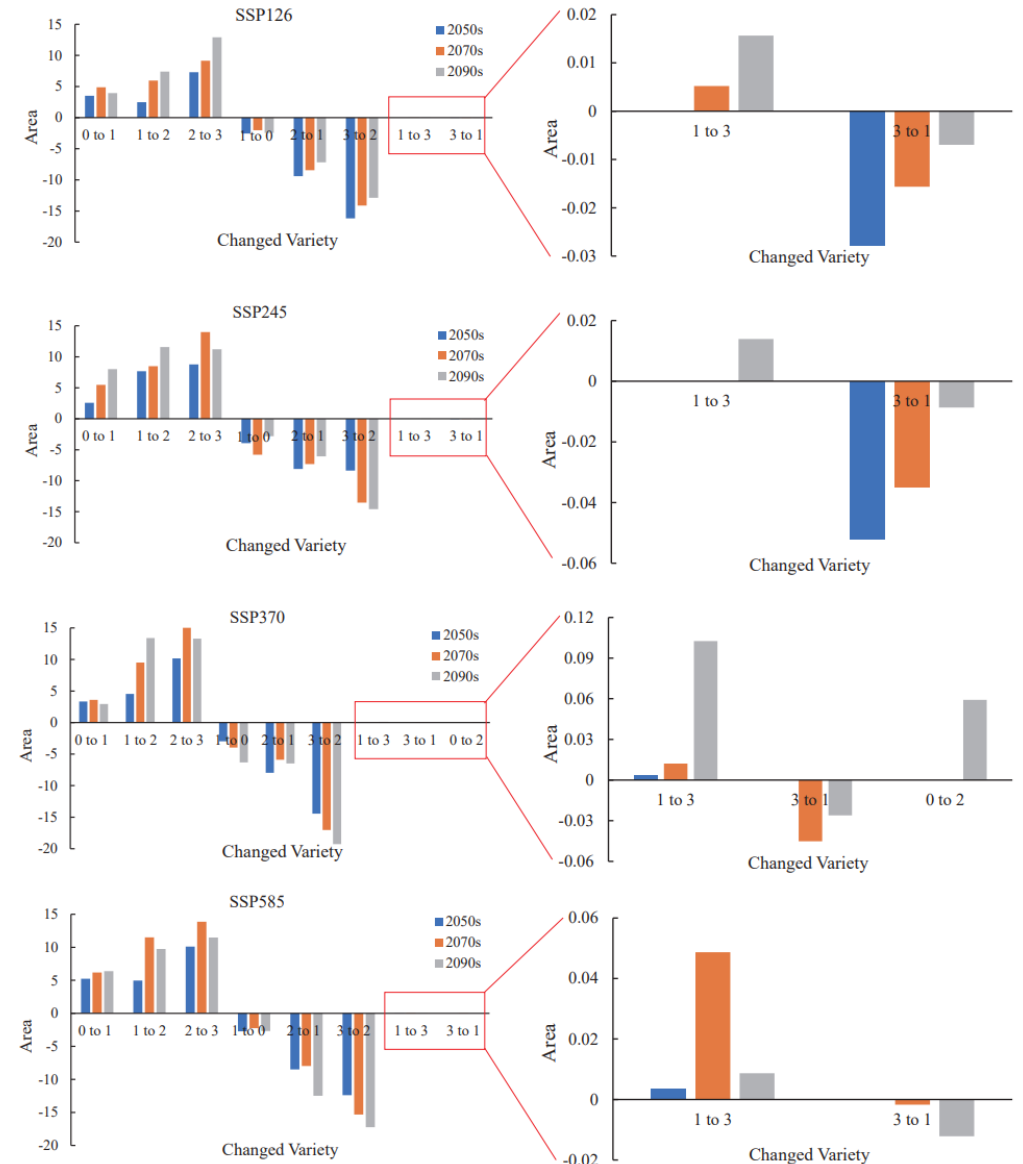
Figure 7. The area changes of current habitats distribution to the projected future distribution at 2050s (2041–2060), 2070s (2061–2080), and 2090s (2081–2100) for tea. The longitudinal axis is the change of area (10 4 km 2 ), in which the positive value is the increase of suitability and the negative value is the decrease of suitability; “0” indicates Unsuitable habitat, “1” indicates Marginal suitable habitat, “2” indicates Medium suitable habitat, “3” indicates Optimal suitable habitat .